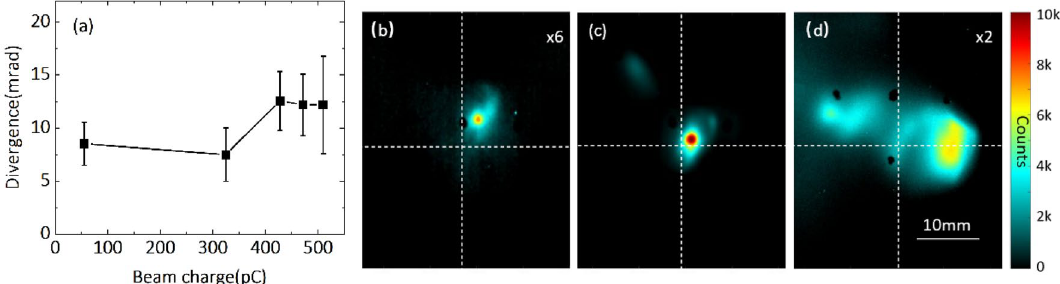
Figure 4. ( a ) Variation of beam divergence with the beam charge of an electron bunch. Here the beam charge of an electron bunch is enhanced as the laser fluence increases from 84 to 176 J/cm 2 . ( b–d ) Raw data of the beam distribution of an electron bunch recorded on Lanex 1. The ablation laser fluence is ( b ) 84, ( c ) 145 and ( d ) 210 J/cm 2 .